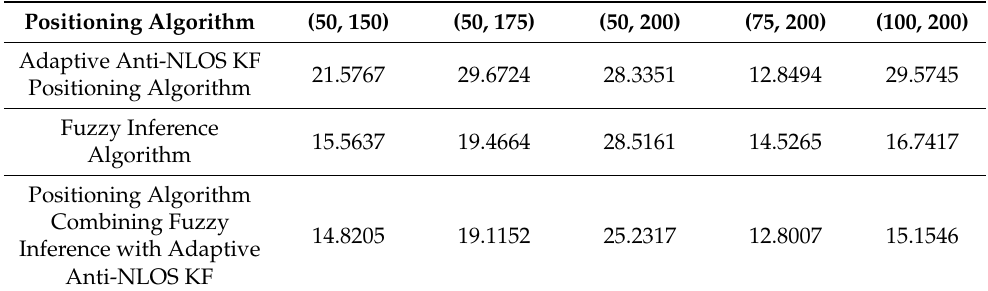
Table 2. RMSEs of static positioning under NLOS conditions.